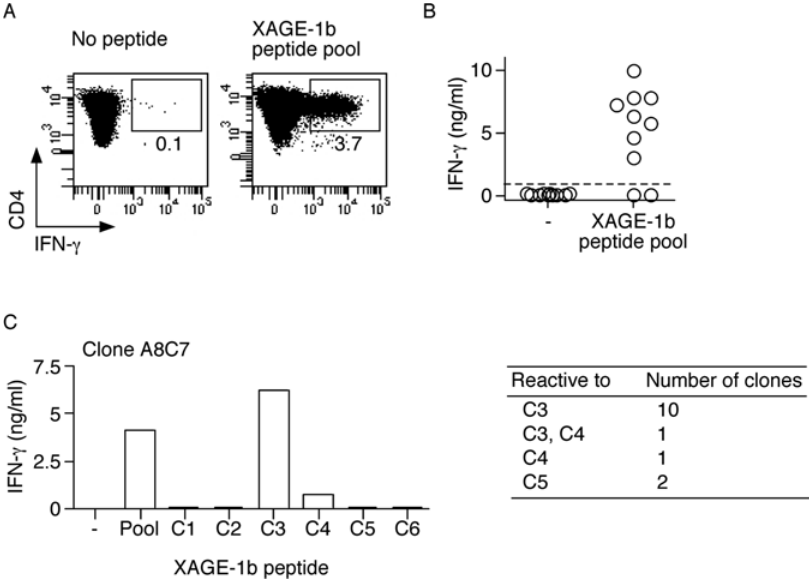
Fig 3. Isolation of XAGE-1b specific CD4 + T cells and generation of specific clonal populations. (A) XAGE-1b specific CD4 + T cells were isolated by IFN- γ capture assay. Numbers indicated in the upper right region of dot plots show the percentages of IFN- γ producing cells among the CD4 + T cells, after stimulation in the absence or in the presence of the peptide pool. IFN- γ producing cells were sorted and cloned under limiting dilution conditions. (B) CD4 + T-cell clones were obtained and screened to assess reactivity to XAGE- 1b. Clones were stimulated in the presence or the absence of the peptide pool and specificity to XAGE-1b was determined by ELISA. Responses were considered significant when the amount of IFN- γ detected in the presence of peptide was at least 3-fold higher than that detected in the absence of peptide. (C) Aliquots of XAGE-1b specific CD4 + T-cell clones were stimulated in the absence or presence of the peptide pool or of individual single peptides and the amount of IFN- γ was measured in 24-hour culture supernatants by